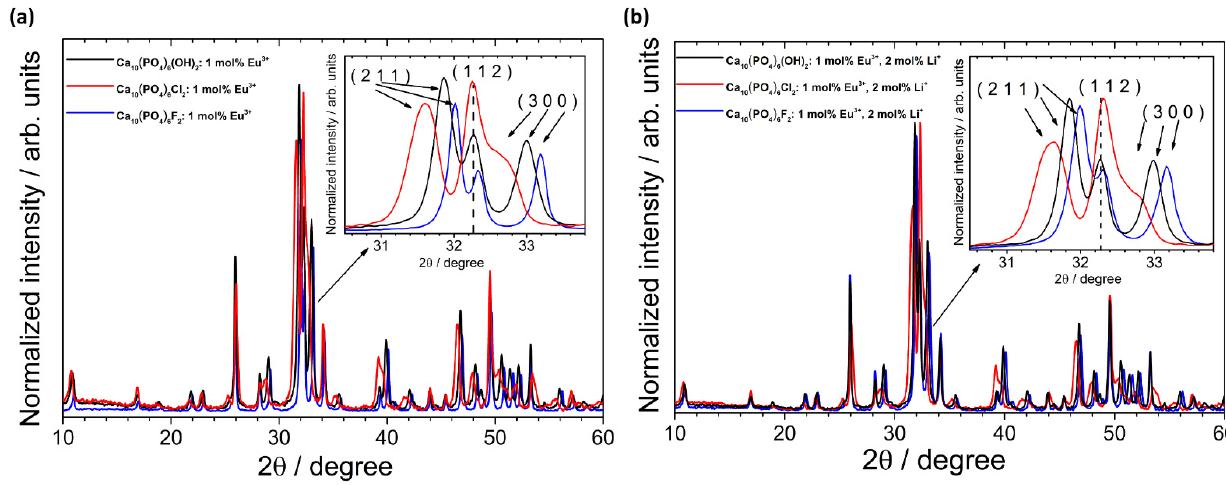
Figure 3. XRPD patterns of the HAp, ClAp and FAp doped with 1 mol% Eu 3+ ( a ) and co-doped with 1 mol% Eu 3+ and 2 mol% Li + ( b ) with the indication of lattice planes shift induced by various types of anions (inset).